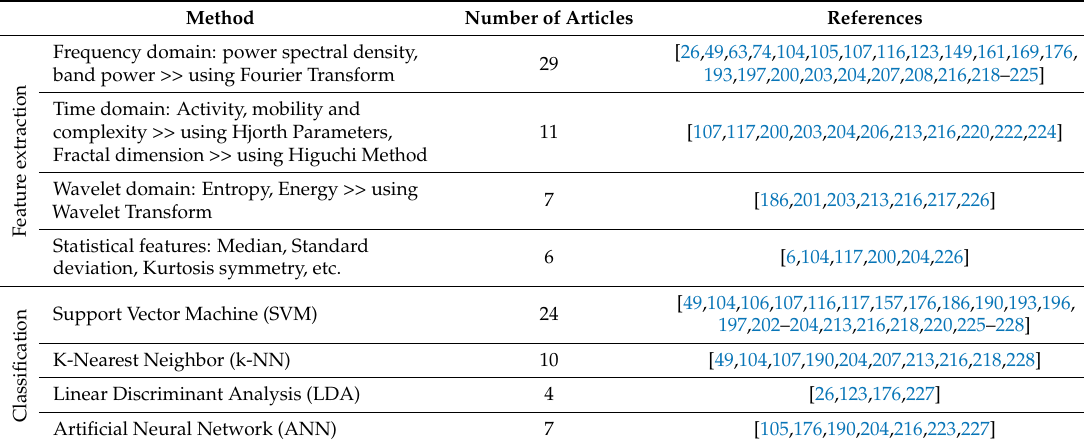
Table 5. Computational methods to extract and classify emotional features from